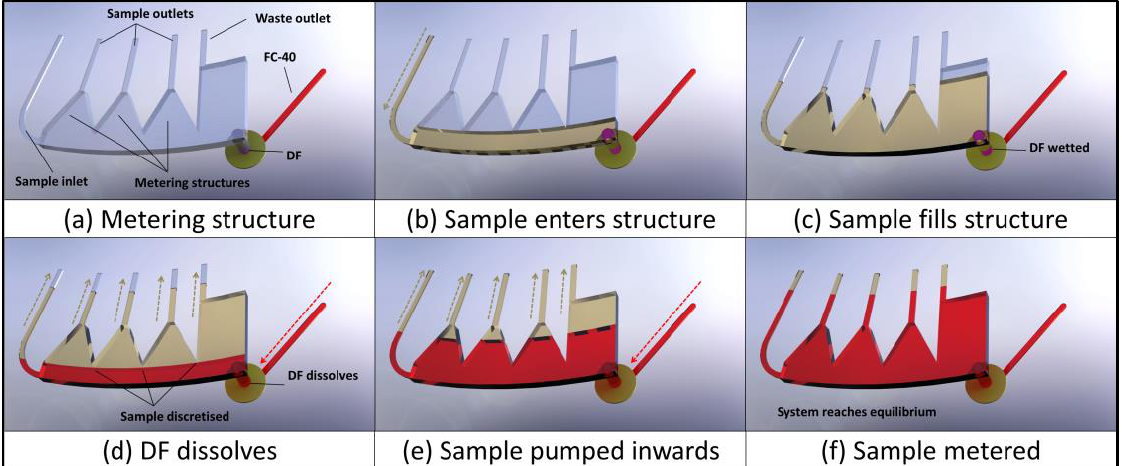
Figure 6. Schematic of metering function. Here, the sample is aliquoted into three identical volumes. ( a ) Metering structure. ( b ) The sample (yellow) enters the system and wets the DF. ( c ) The sample fills the structure. Within the 40 s dissolution time of the DF, the filling of the metering structure completes. ( d ) FC-40 (red) is released and centripetally displaces the lighter sample. The sample aliquots are isolated once their outer end has fully risen into the V-shaped metering structures. ( e , f ) The system seeks hydrostatic equilibrium by centripetal pumping of the aliquoted and metered samples.